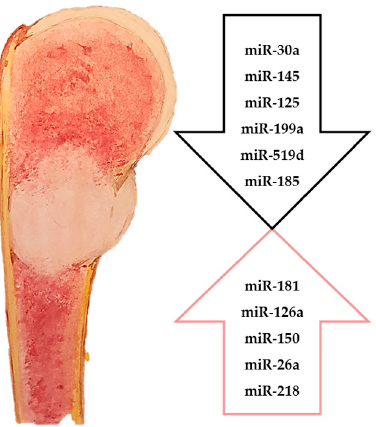
Figure 1. Downregulated and upregulated miRNAs in chondrosarcoma.